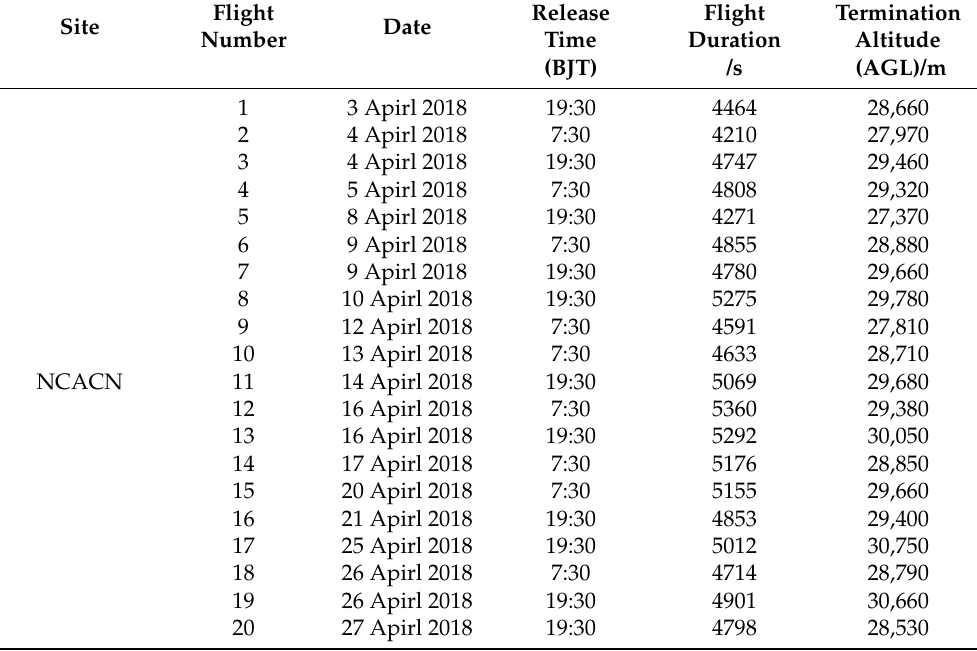
Table A2. NCACN radiosonde